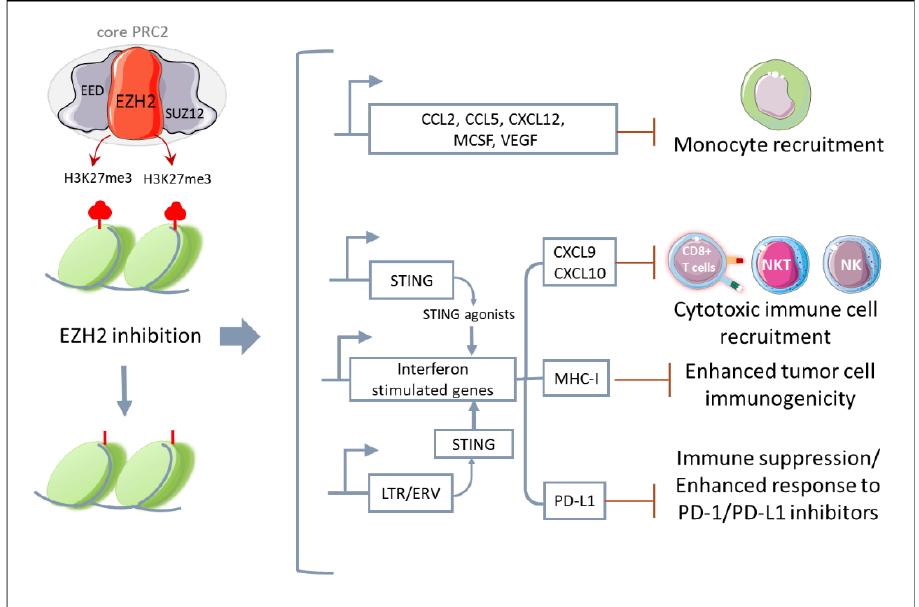
Figure 3. EZH2 modulates anti-tumor immunity. EZH2 inhibition leads to the epigenetic repro- graming of cancer cells, which upregulates transcriptional programs associated with increased tumor cell immunogenicity and recruitment of cytotoxic immune effector cells, but also monocytes and immunosuppressive molecules such as PD-L1. This suggests that combinatory strategies tar- geting the tumor-infiltrating immune cells, such as anti-PD-1/PD-L1 antibodies, might synergize with EZH2. (STING, stimulator of interferon genes; CXCL9, CXC motif ligand chemokine ligand 9; CXCL10, CXC motif ligand chemokine ligand 10; MHC 1, Major histocompatibility complex 1; LTR, Long termina repeat; EVR, endogenous retrovirus; PD-L1, programmed death-ligand